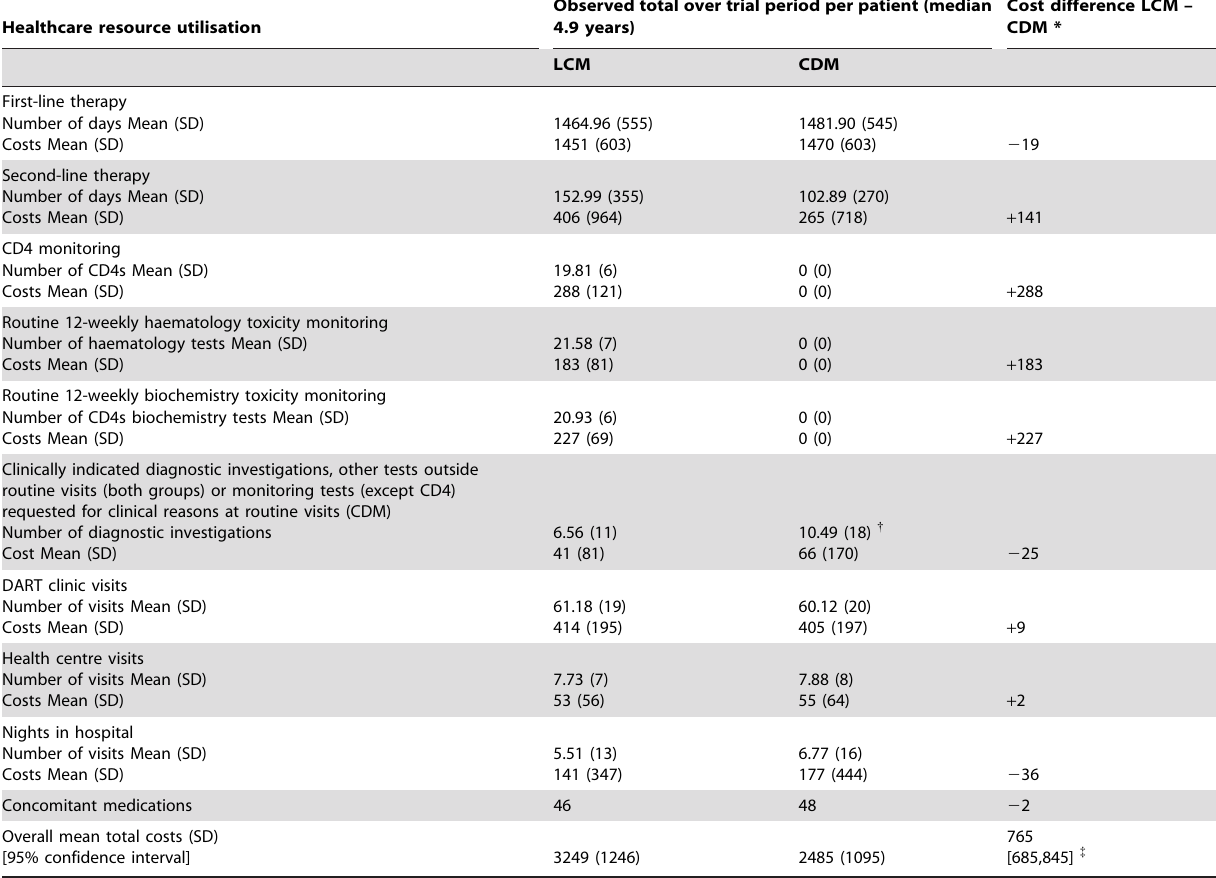
Table 2. Healthcare resource utilisation (US $